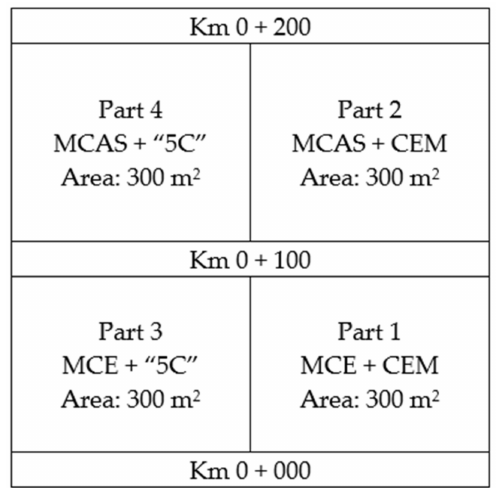
Figure 3. Diagram showing the division of the test section.